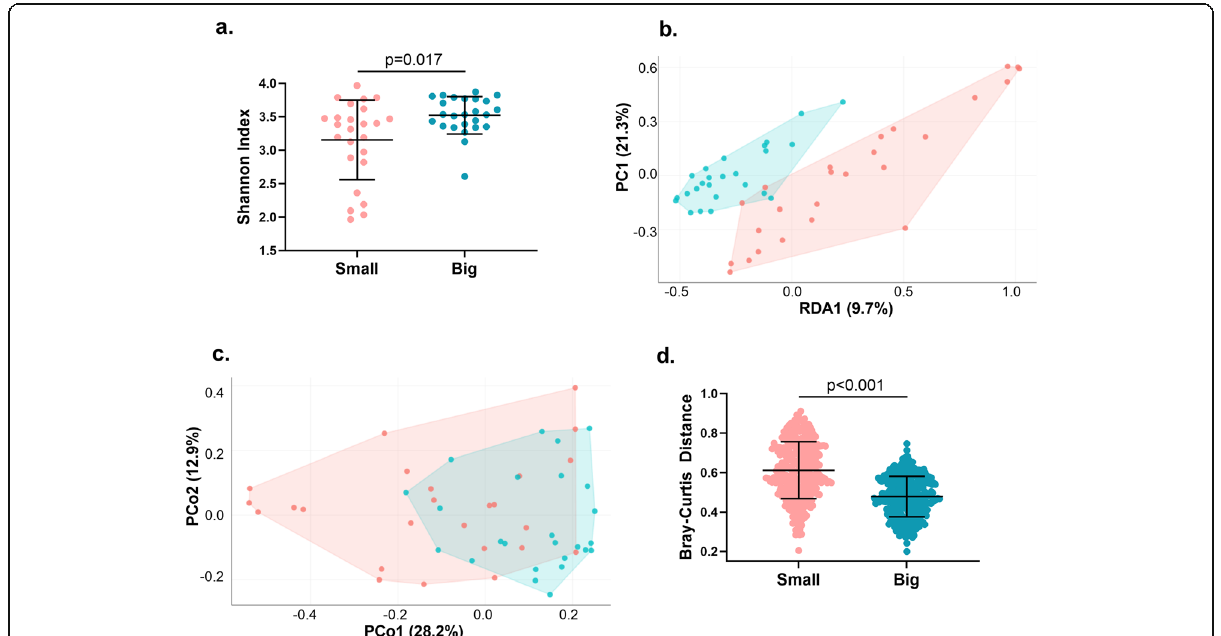
Fig. 2 a Alpha diversity (Shannon Index) of ceca of Small and Big broilers. Big birds had significantly higher diversity ( p = 0.017; Wilcoxon rank sum test). b Beta diversity (RDA ordination) plot of cecal samples constrained to the variable “ Small/Big ” . An almost complete separation between the groups is observed. Less interindividual variation occur between the big birds compared to the small birds. The relative contribution (eigenvalue) of each axis to the total inertia in the data as well as to the constrained space only, respectively, are indicated in percent at the axis titles. c Beta diversity ( PCoA) plot based on Bray-Curtis dissimilarity matrix. The relative contribution (eigenvalue) of each axis to the total inertia in the data is indicated in percent at the axis titles. d Bray-Curtis dissimilarity in Small and Big chickens. The interindividual variation was tested using by pair-wise comparisons of within-group Bray-Curtis dissimilarities. The values can be between 0 and 1, with 0 meaning identical communities and 1 meaning there is no overlap in the communities. Significance was tested using non-parametric Wilcoxon rank sum test. RDA = Redundancy Analysis. PCoA = Principal Coordinates Analysis. Solid lines indicate mean with